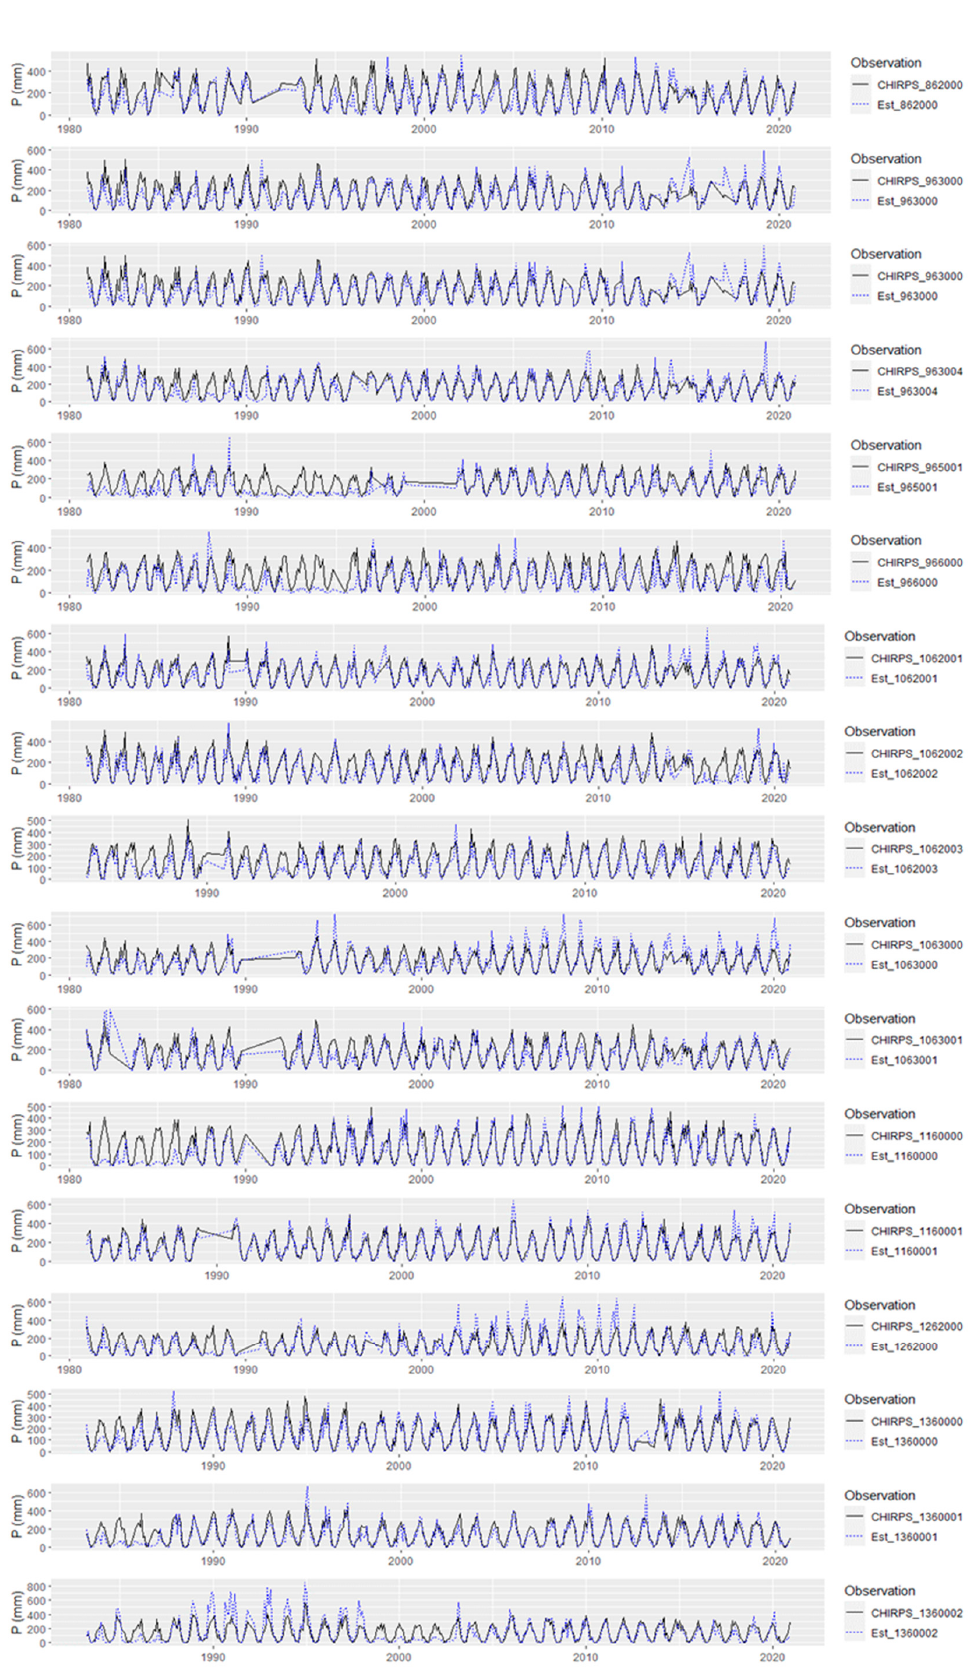
Figure 2. Overlay of each rain gauge data and the CHIRPS data for that pixel.